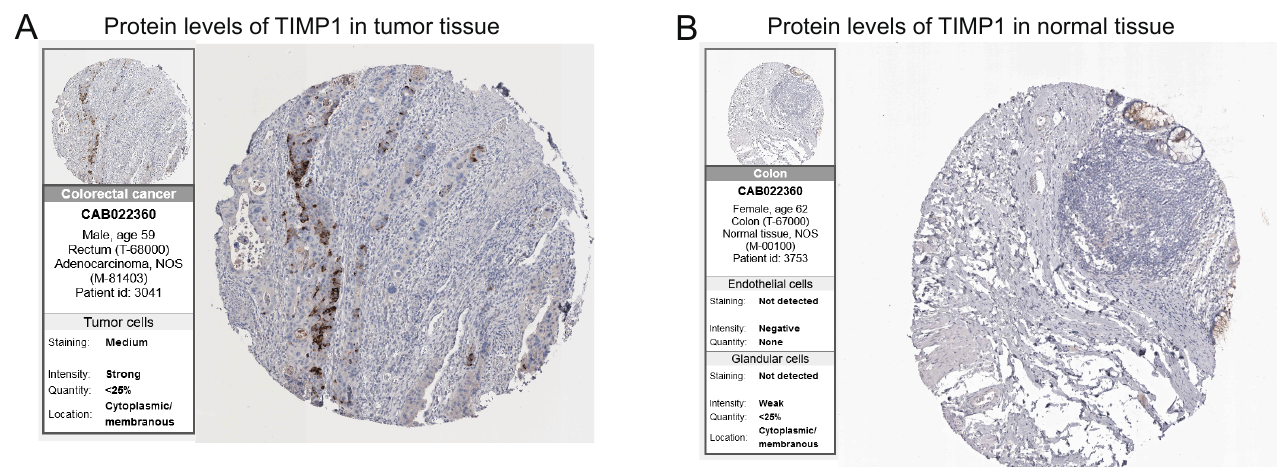
Figure 10. Immunohistochemistry of the TIMP1 gene in tumor and normal tissues from the human protein atlas (HPA) database. ( A ) Protein levels of TIMP1 in tumor tissue. ( B ) Protein levels of TIMP1 in normal tissue.